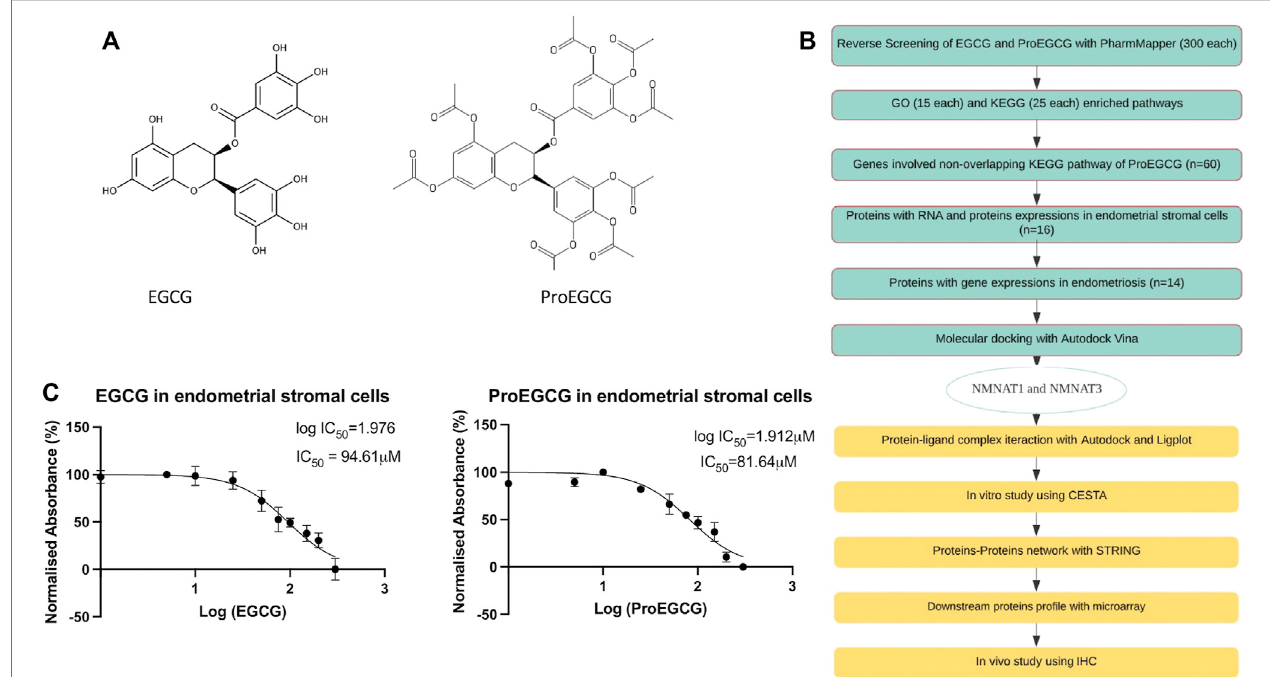
FIGURE 1 | Study design. (A) Chemical structures of small molecules EGCG (left) and ProEGCG (right) . (B) Flowchart of methodology applied to identify and analyse the potential targets of EGCG and ProEGCG through various platforms. (C) MTT proliferation assays on human endometrial stromal cells after treatments of EGCG (left) andProEGCG (right) inarangeof0 – 300 μ Mfor48 h.Normalisedabsorbance(%)vs.Log(drugconcentrations)wasplottedasmean ± SD( n (cid:1) 3)andIC50 value was calculated usingGraphPad Prism version 8.4.2.